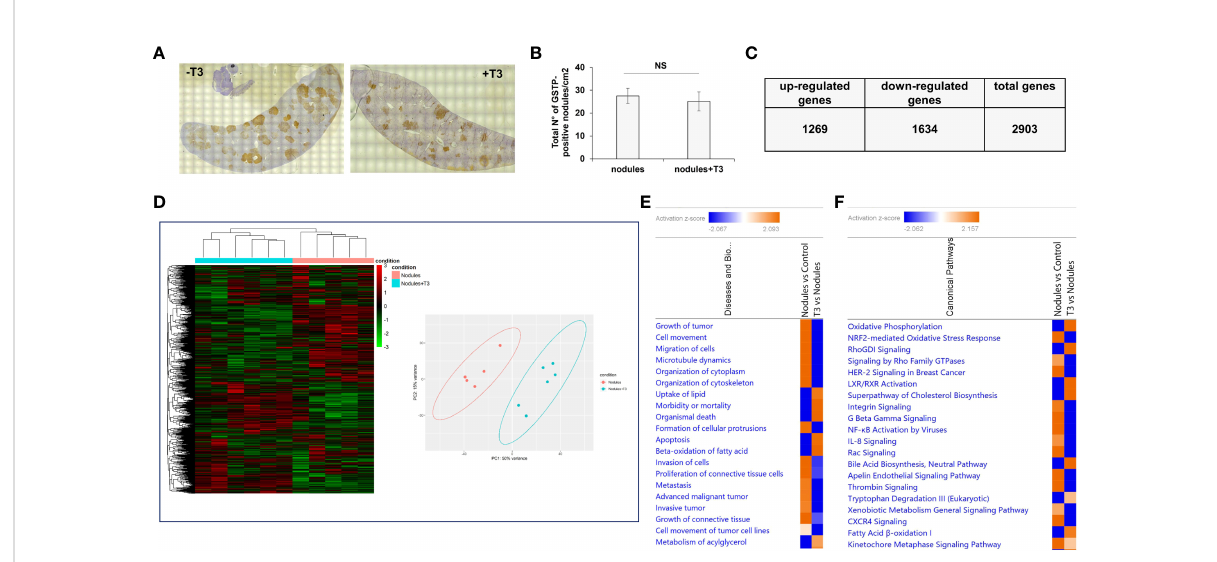
FIGURE 2 T3 modi fi es the global gene expression pro fi le of preneoplastic lesions. (A) An overview of GSTP immunohistochemical staining of representative preneoplastic lesions of untreated (-T3) or 4-day T3 treated animals (+T3); (B) Number of GSTP-positive preneoplastic nodules in rat livers subjected to the R-H protocol and then treated with T3 or not for 4 days; (C) Up- and down-regulated genes in nodules of rats fed T3 for 4 days vs . preneoplastic nodules of untreated animals; (D) Hierarchical clustering of genes in untreated preneoplastic lesions (nodules) or treated with T3 for 4 days (nodules+T3). Each row represents the expression of a gene and each column a sample. Red and green colors represent higher or lower mRNA expression levels (median-centered), respectively (Left), and Principal component analysis (PCA) indicative of the variability of gene expression data in nodules of rats untreated or treated with T3 for 4 days (right); (E) Top 20 diseases and functions identi fi ed by IPA core analysis in untreated nodules vs . control and T3-treated nodules vs. untreated nodules; (F) Top 20 Canonical Pathways identi fi ed by IPA Core Analysis in untreated nodules vs . control and T3-treated nodules vs. untreated nodules. Color is determined by Z-score; the Z-score >2 and <-2 is considered meaningful. Blue color indicates suppressed disease/biological function or canonical pathways; orange indicates activated disease/biological function or canonical